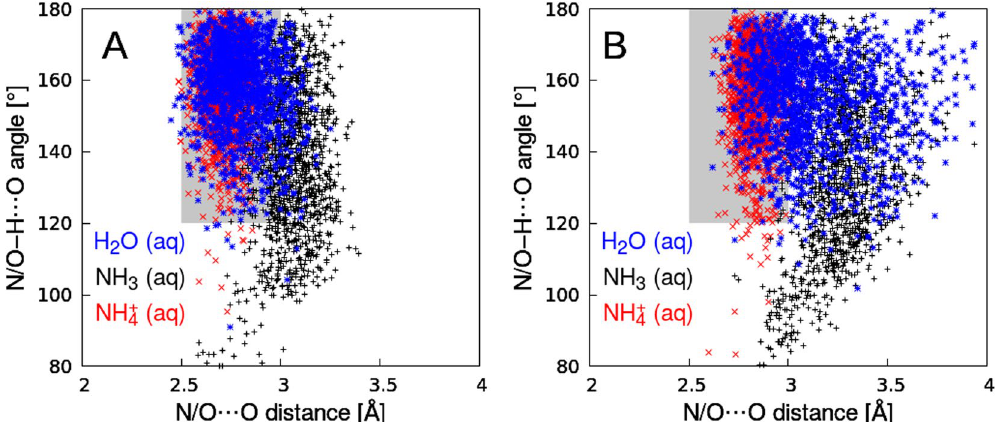
Figure 1. Hydrogen-bond strengths of liquid water (blue, square symbols), ammonia (black, plus symbols) and ammonium (red, cross symbols) aqueous solutions. Two parameters characterize the hydrogen-bond strength: The N  O distance (O  O for water) and the N/O–H  O angle. Panel (A) shows data for the strongest hydrogen bond (i.e., shortest) and panel (B) corresponds to the second-strongest hydrogen bond. The shaded areas indicate the parameter ranges typically considered for strong hydrogen bonding 27 .